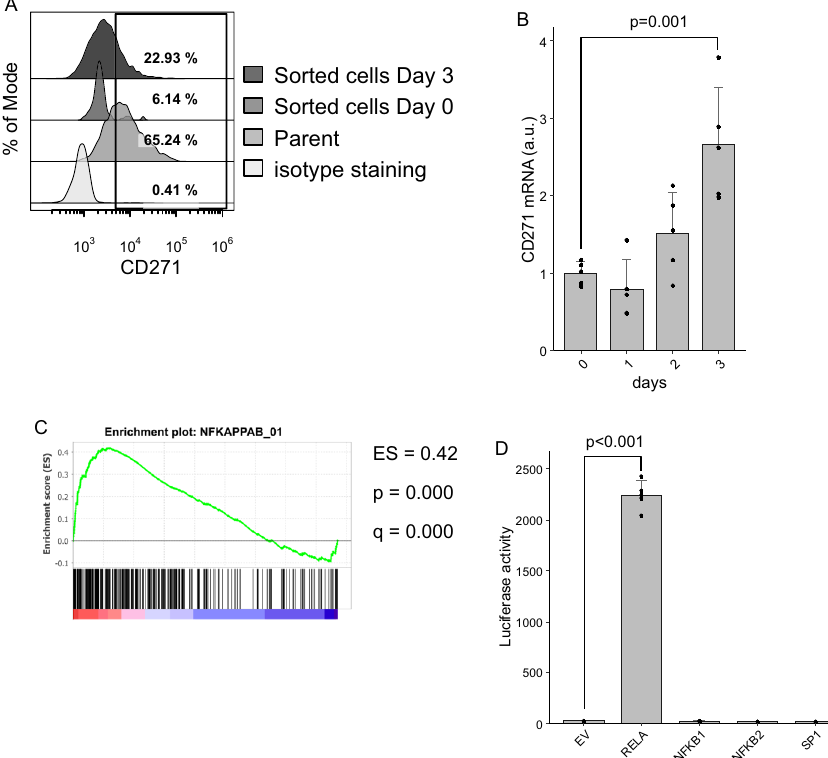
Figure 1. Screening transcription factors potentially involved in CD271 expression. ( A ) Representative data of CD271 expression in HPCM2 cells. HPCM2 cells were sorted into a CD271-low fraction and cultured for 3